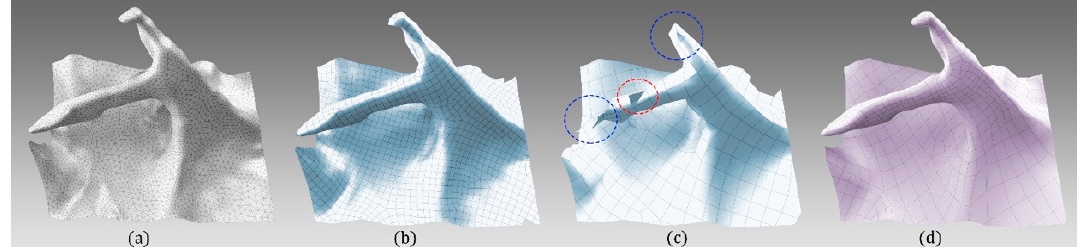
Figure 9. Porcupinefish: 3D model ( a ); detail ( b ); simplification process, using automatic isotropic meshes of quadrangular polygons ( c ) or manual retopology with quads of different size ( d ).